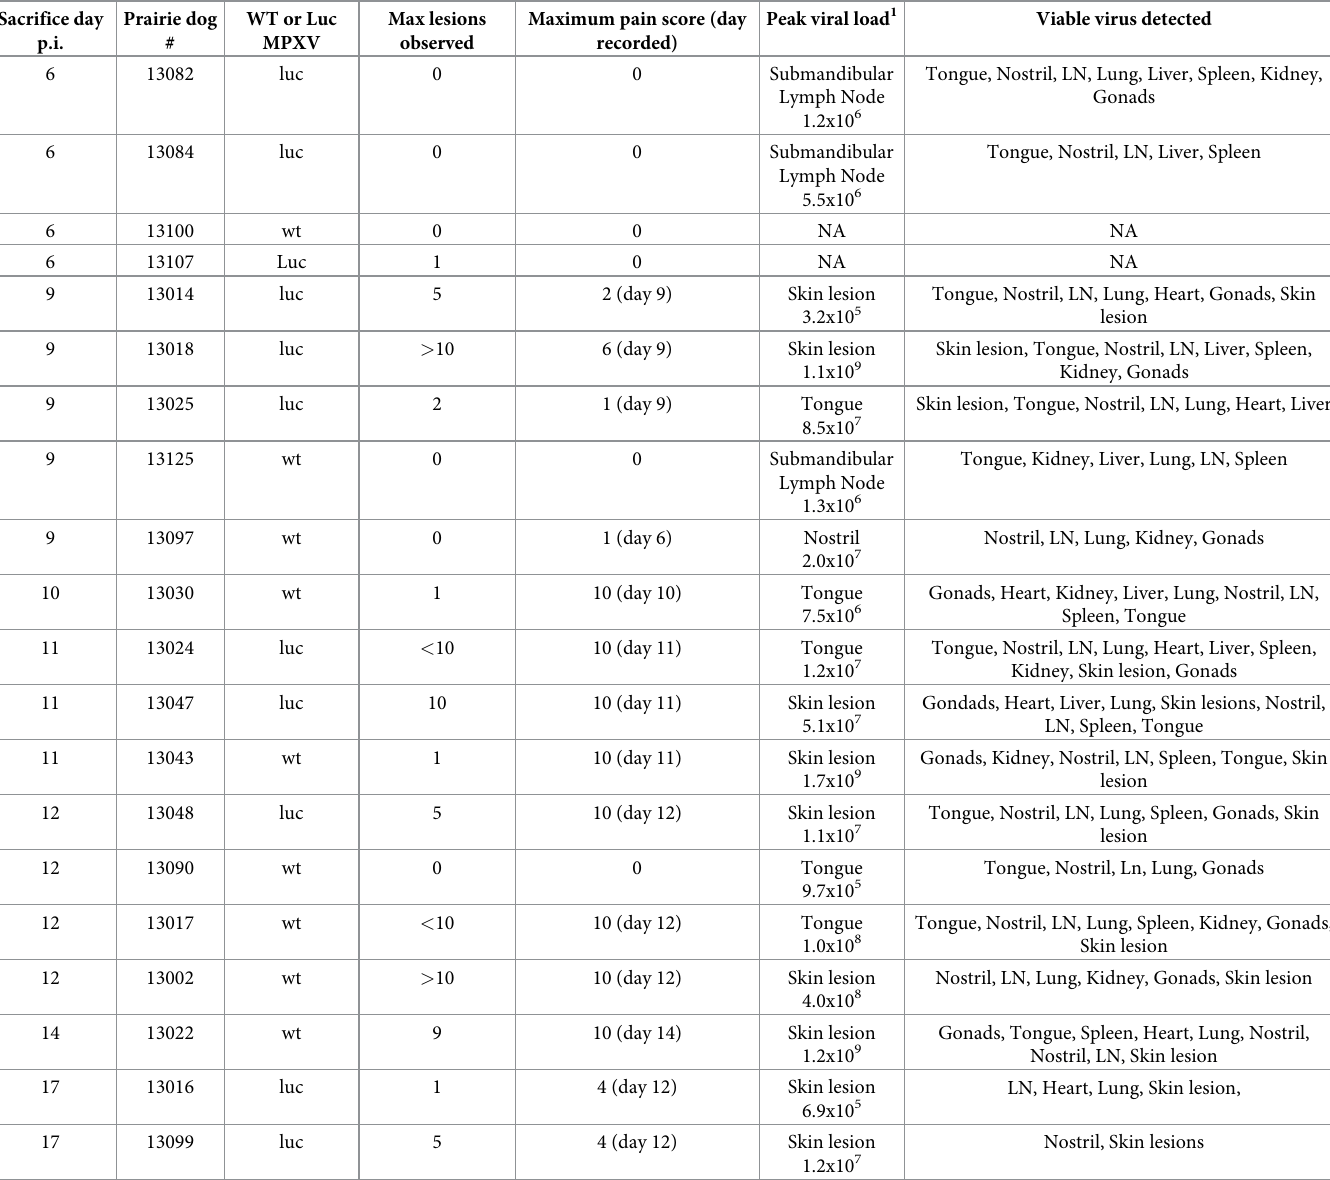
Table 1. Clinical and laboratory findings in prairie dogs intranasally challenged with WA MPXV. Sacrifice day